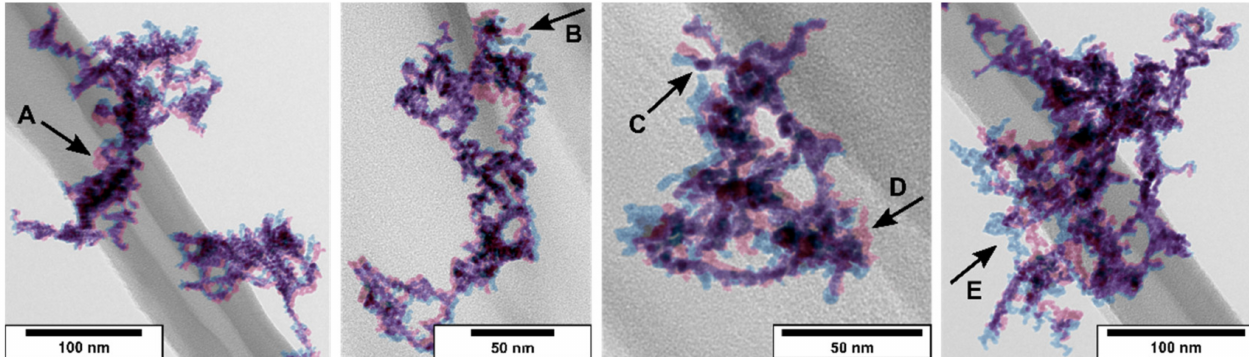
Figure 6. TEM micrographs for N 2 (blue) and H 2 (red). A, B, E: Shift of a compact part to another position. C: Rotation of a branch around a pivot point. D: Particle branch turns from the z -axis into the x -/ y -axis of the micrograph. As marked by black arrows, a mobilization of certain branches could be